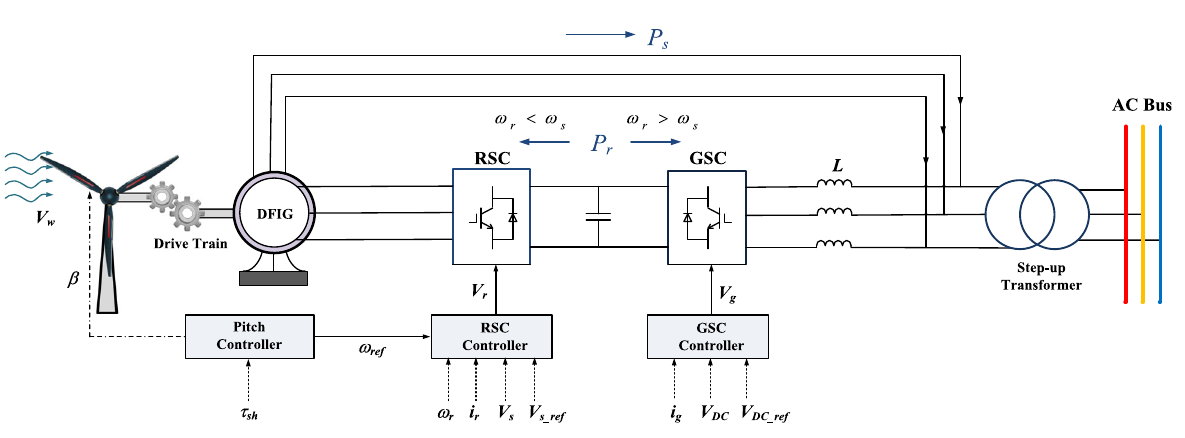
Fig. 1 DFIG based wind energy system connected to the grid